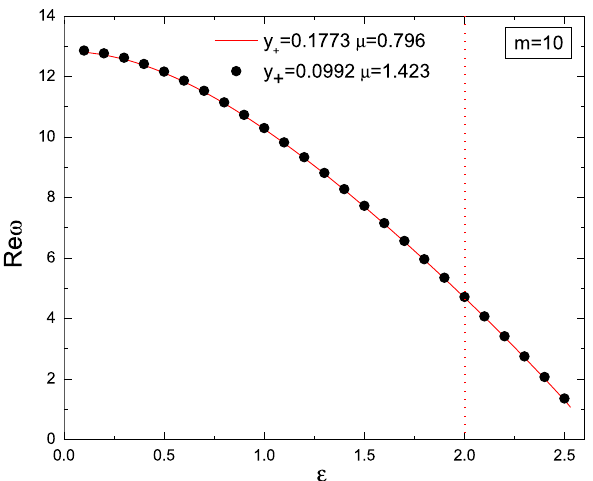
. The values of μ are y +